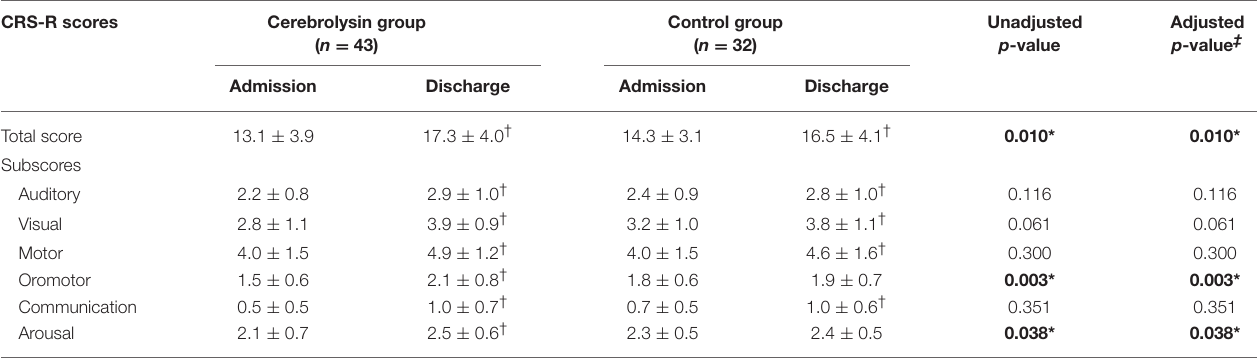
TABLE 2 | Comparison of CRS-R scores at admission and discharge between Cerebrolysin and control groups.